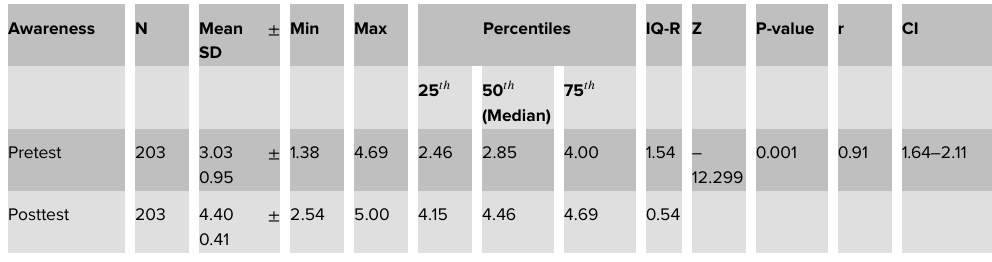
Table 3: Comparing stakeholder’ awareness at the pre- and posttests ( N =